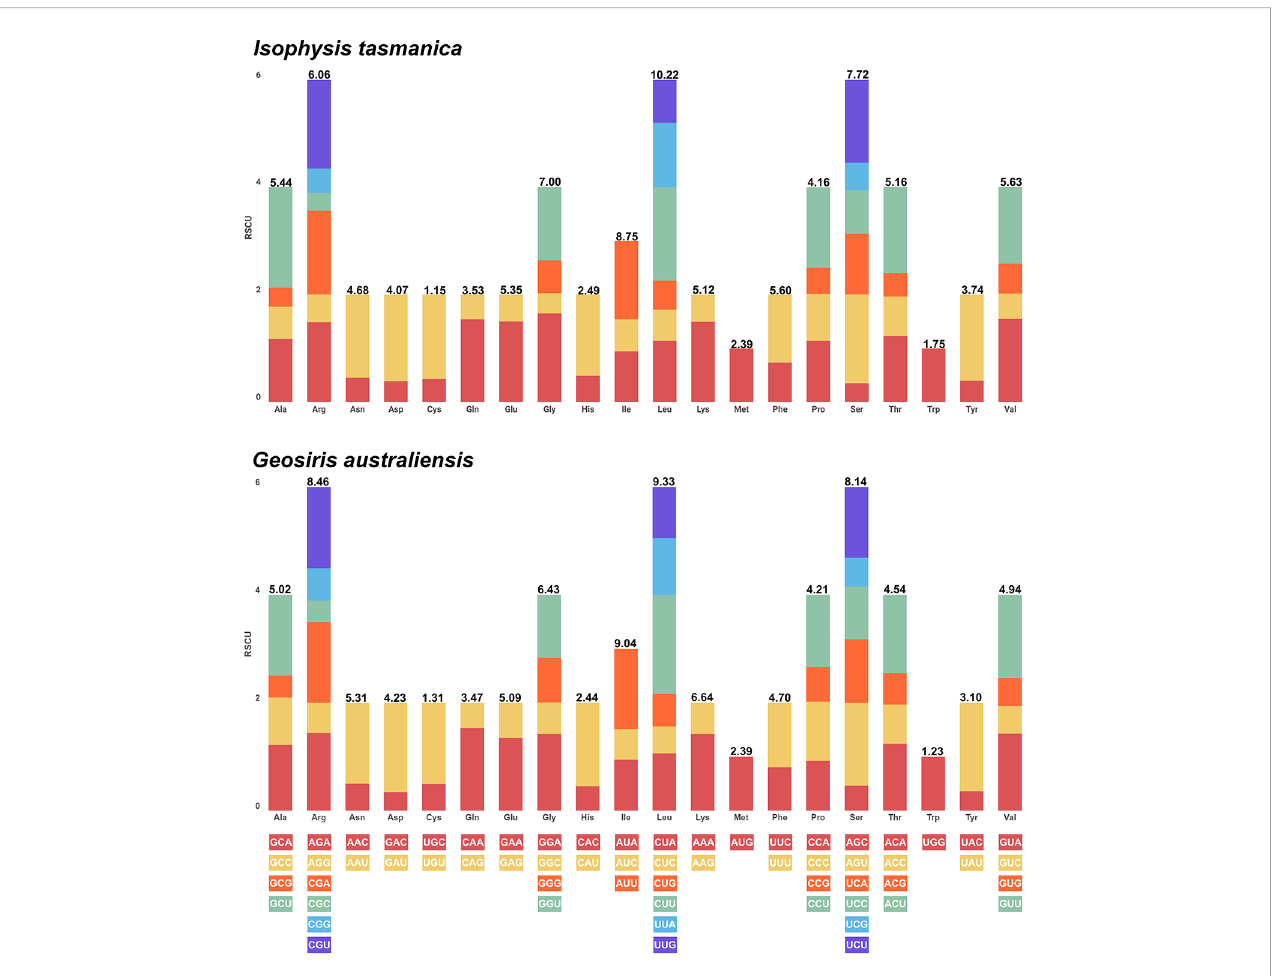
FIGURE 5 Number of codons and relative synonymous codon usage values of the plastid genome of representative autotrophic ( Isophysis tasmanica ) and mycoheterotrophic ( Geosiris australiensis ) species of